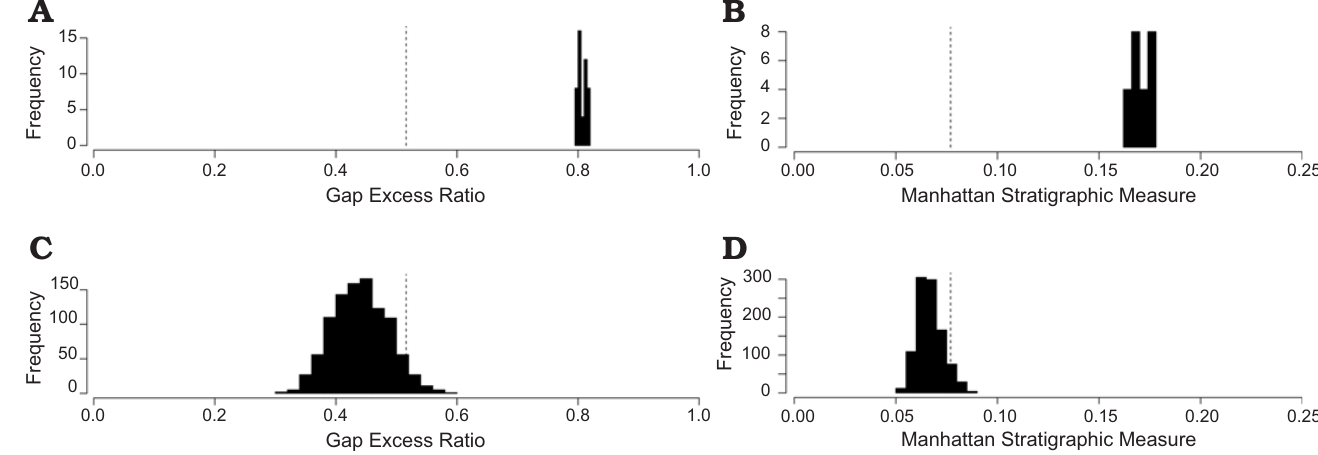
Fig. 7. Histograms indicating the level of stratigraphic fit of the 48 input trees ( A , B ) versus the randomly generated topologies ( C , D ). Only the results for the Gap Excess Ratio ( C ) and the modified Manhattan Stratigraphic Measure ( D ) are shown here. The vertical dashed line represents the critical value at which 95% of trees fail the randomization test. Thus, all 48 MPTs trees show a significantly better fit to stratigraphy than expected at